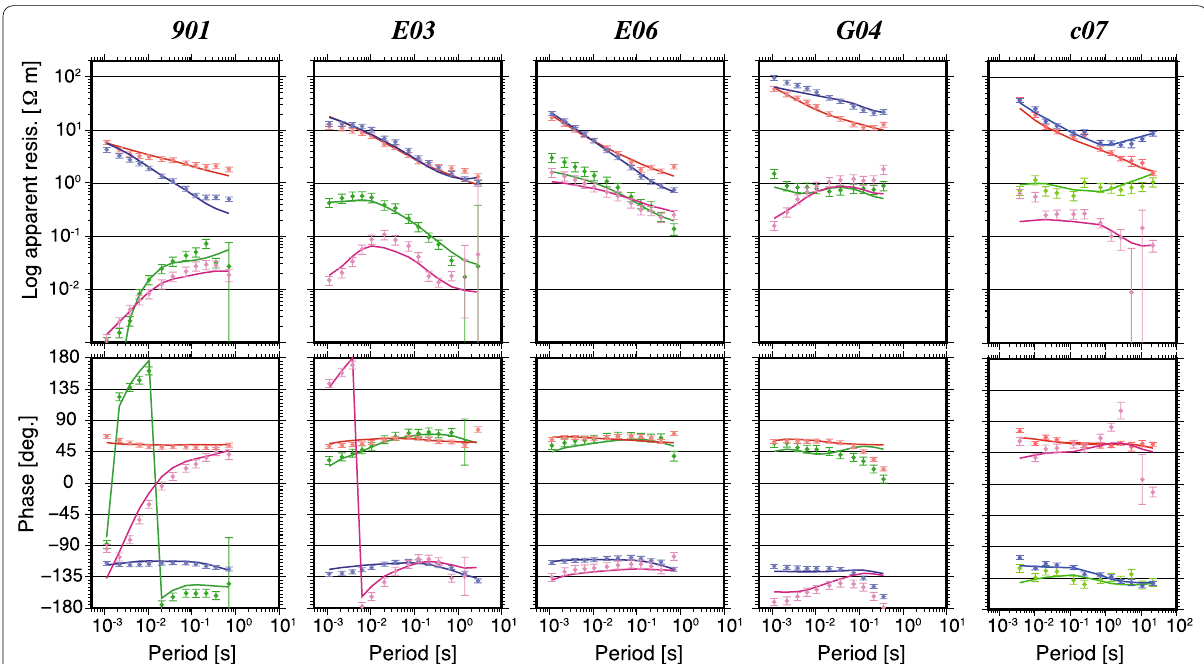
Fig. 3 Apparent resistivity and impedance phase determined via observations (symbols) and calculations (solid lines). Apparent resistivities (upper panel) and impedance phases (lower panel) obtained for the five sites in the study area are shown. The off-diagonal components, Z XY and Z YX , are shown in red and blue, respectively. The diagonal components, Z XX and Z YY , are shown in green, and pink,